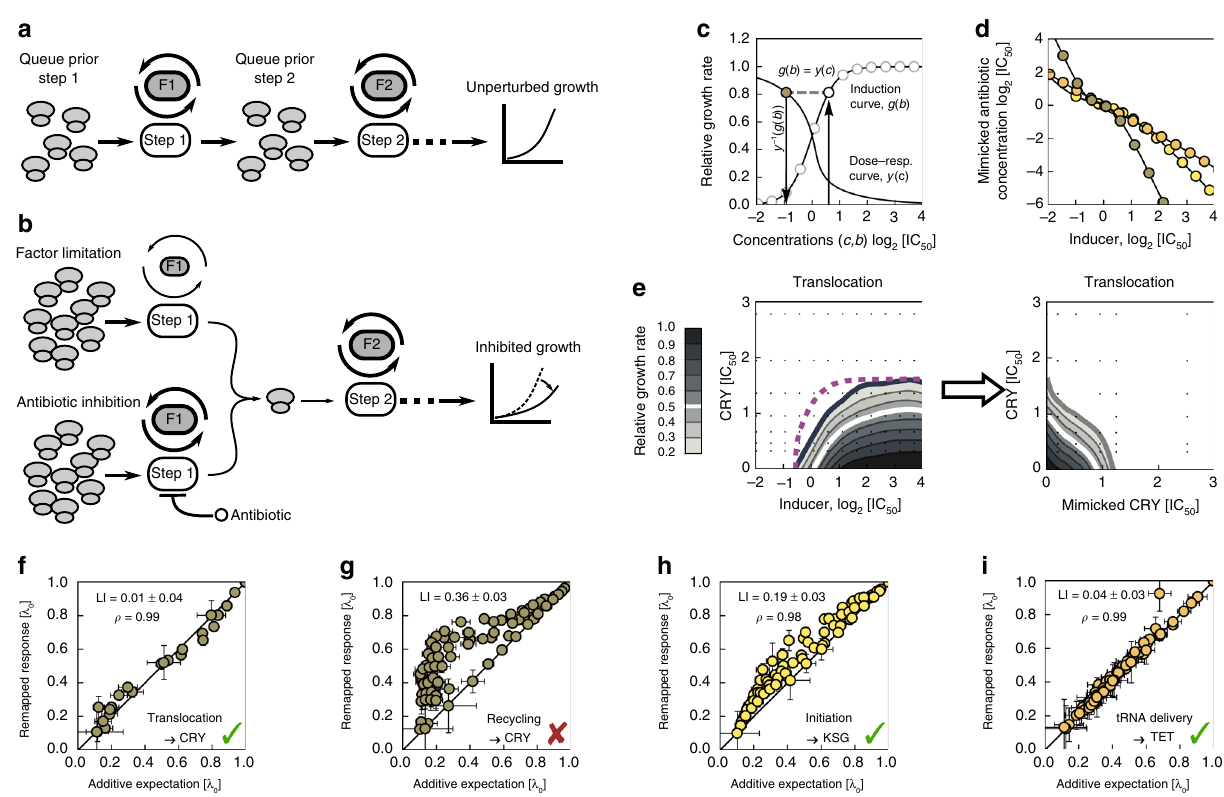
Fig. 4 Translation factor deprivation mimics the action of equivalent antibiotics. a Schematic of translation as a sequence of steps (white), catalyzed by translation factors (gray). In the absence of perturbations, ribosomes progress through the steps unimpeded, resulting in unperturbed growth. b Schematic of perturbed translation. Top: as the abundance of factor F1 is lowered (smaller factor symbol), the rate of step 1 decreases (thinner arrows) and ribosomes queue in front of the bottleneck. Bottom: the same rate is reduced by an antibiotic. The effects of factor deprivation and antibiotic action on growth are equivalent. c Schematic of conversion of inducer concentration b (here for the translocation factor) into the mimicked antibiotic concentration c (here: CRY). For each inducer concentration b , the growth rate from the induction curve g ( b ) is determined and the same growth rate on the antibiotic dose – response curve y ( c ) is identi fi ed (gray dashed line); the inverse function of the dose – response curve yields the equivalent antibiotic concentration as c ¼ y (cid:2) 1 g ð b Þð Þ . d The resulting conversion of inducer concentration b into antibiotic concentration c for three different pairs of equivalent perturbations: CRY-translocation (gray), KSG-initiation (yellow), and TET-tRNA delivery (orange). e Inducer-antibiotic response surface (left) and mimicked antibiotic- antibiotic response surface (right) upon conversion of inducer concentration as in c , d . Purple dashed line shows isobole for multiplicative responses at relative growth rate 0.2. The remapped response surface is additive, corroborating the equivalence of CRY and translocation factor deprivation. f – i Comparison of response surfaces remapped to the additive expectations. The bottlenecks and antibiotics are shown on the bottom right, respectively. Errors in LI and in expected and remapped responses were evaluated by bootstrapping (Supplementary Methods, Supplementary Fig. 4). f Additive expectation from e and remapped response surface agree ( ρ = 0.99). g As f , but for a recycling bottleneck. The large and statistically signi fi cant discrepancy in LI from 0 indicates that CRY and a recycling bottleneck are not equivalent. h As f , but for KSG and an initiation bottleneck ( ρ = 0.98). i As f